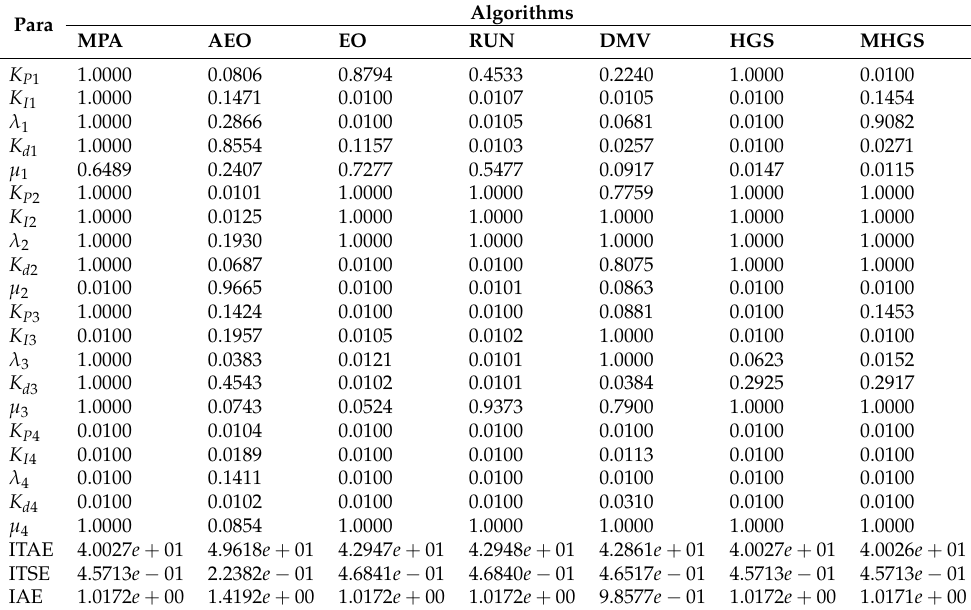
Table 3. The FOPID controller’s identified parameters by the tested techniques in the case of four interconnected units.